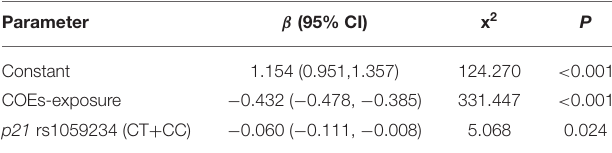
TABLE 5 | Influencing factors of mtDNA copy